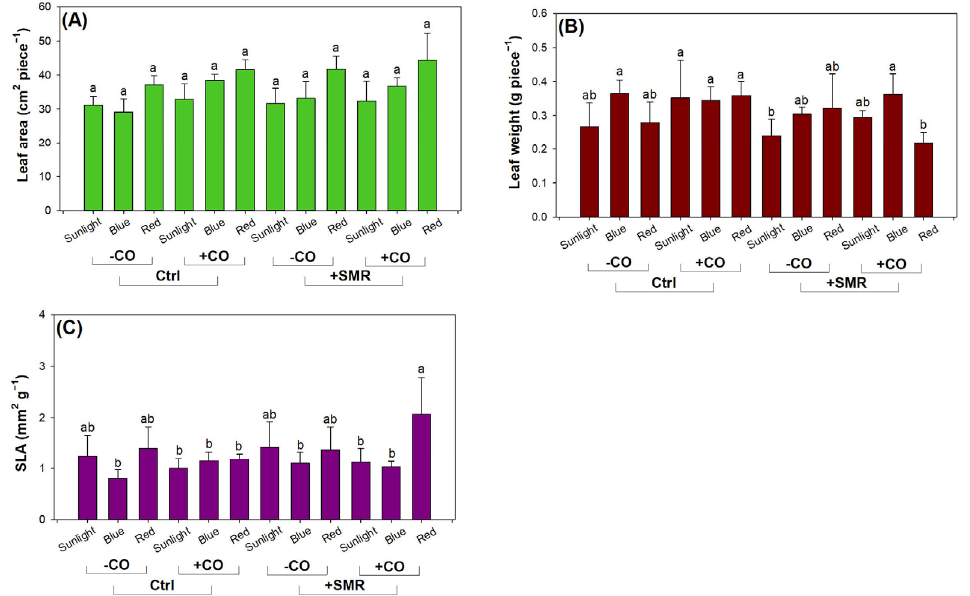
Figure 2. Leaf morphology and weight of black chokeberry ( Aronia melanocarpa (Michx.) Elliott 1821) exposed to combined light-type (sunlight, blue light-emitting diode (LED), red LED), chitosan oligosaccharide (CO), and spent mushroom residue (SMR) treatments: ( A ) combined effects of LED, CO, and SMR on leaf area; ( B ) combined effects of LED, CO, and SMR on leaf weight; ( C ) combined effects of LED, CO, and SMR on specific leaf area. Different letters mark significant difference according to Tukey test at 0.05 level.